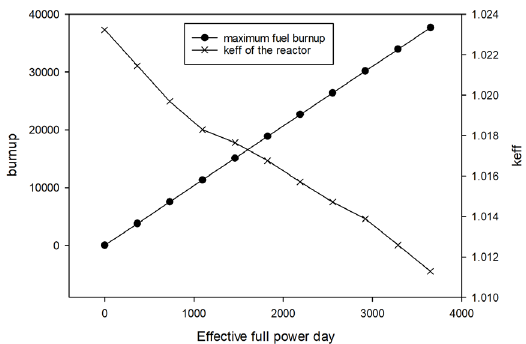
Figure 4. Burnup calculation results of